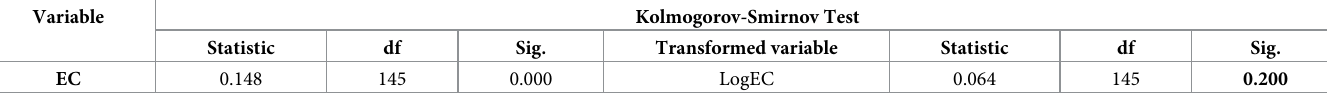
and reflection values. The relationships between EC measurements of soil samples and devel- oped indices and band reflection values were not strong enough. However, linear regression test was used to obtain models for some of the variables which had the highest correlations with the indices. The sensitivity of relationships was tested using variance analysis. The success Table 3. Normality (Kolmogorov-Smirnov) test result of the soil EC and transformed soil